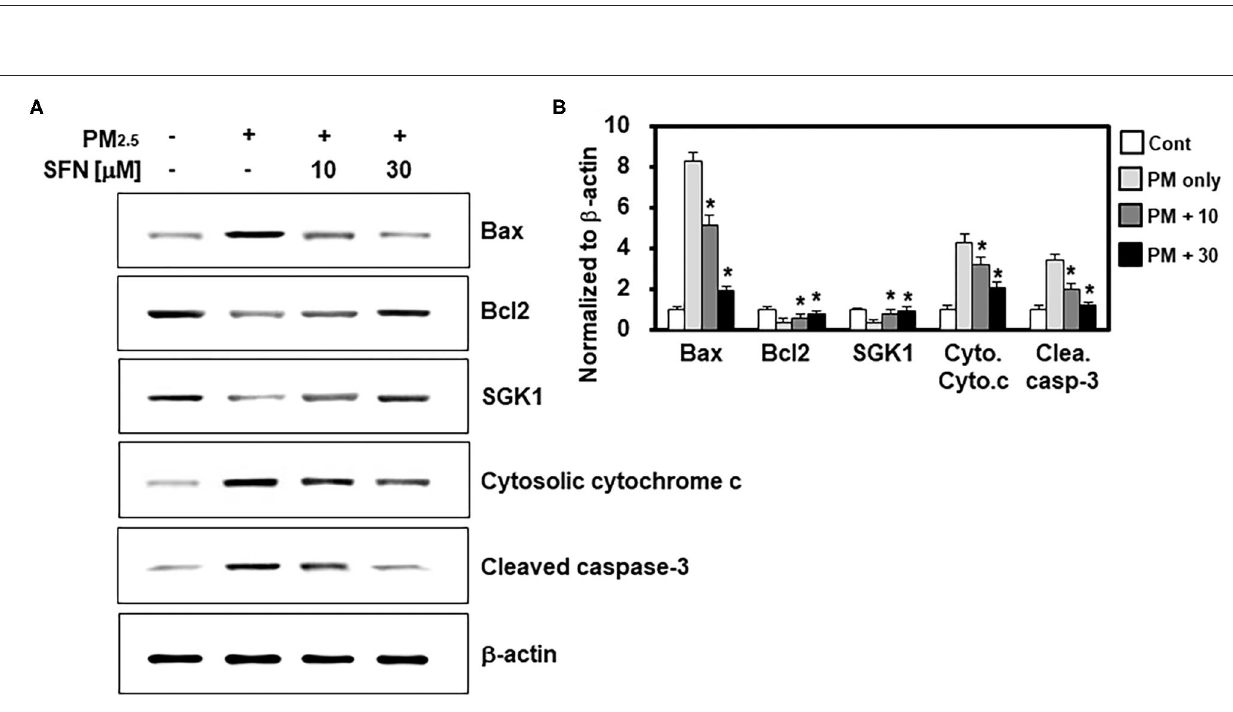
Frontiers in Medicine |